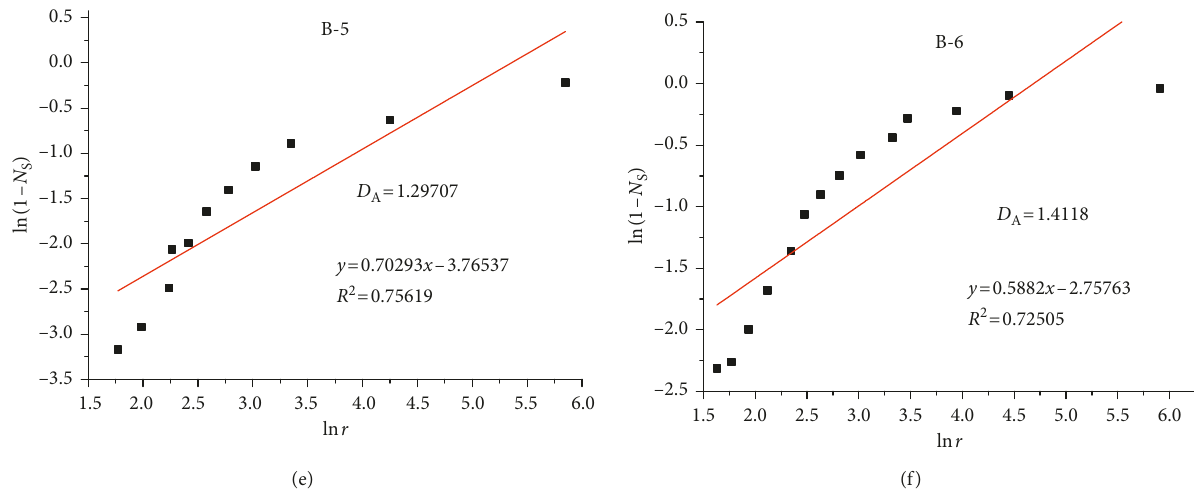
Figure 8: Calculation of pore surface area fractal dimensions for the B-1 to B-6 coal samples.